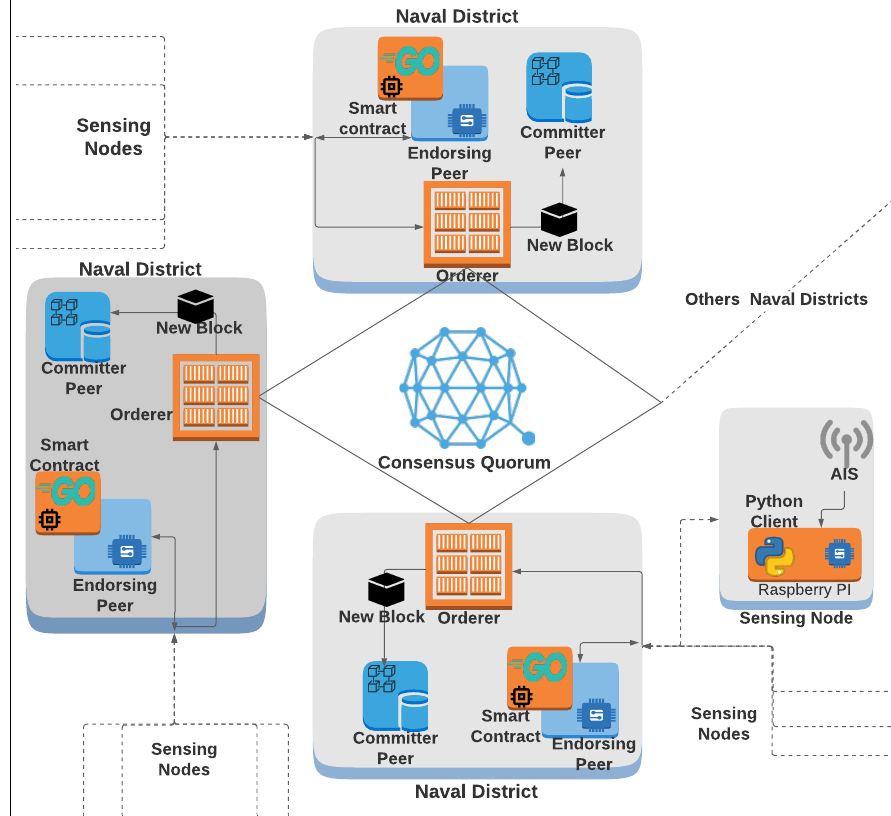
Figure 3. System architecture.